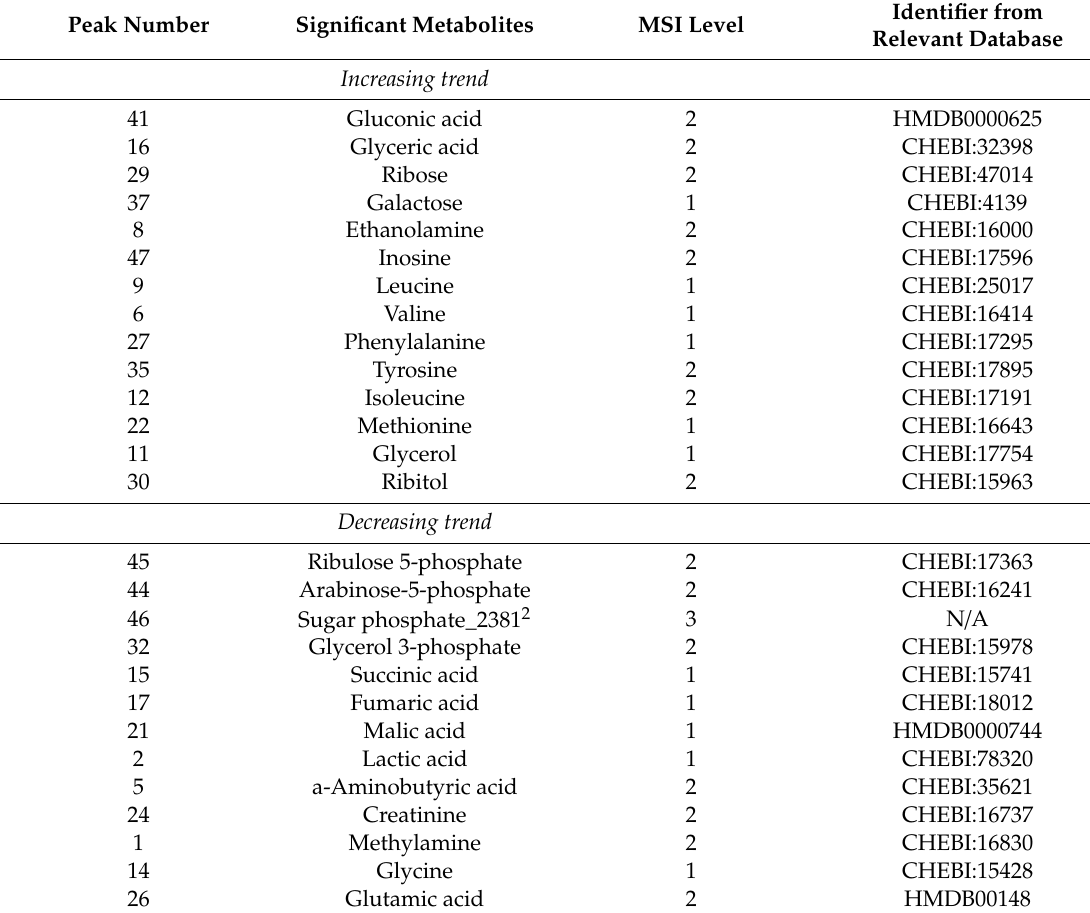
Table 1. Metabolites that either increased or decreased significantly 1 during storage of sea bream on ice. Peak